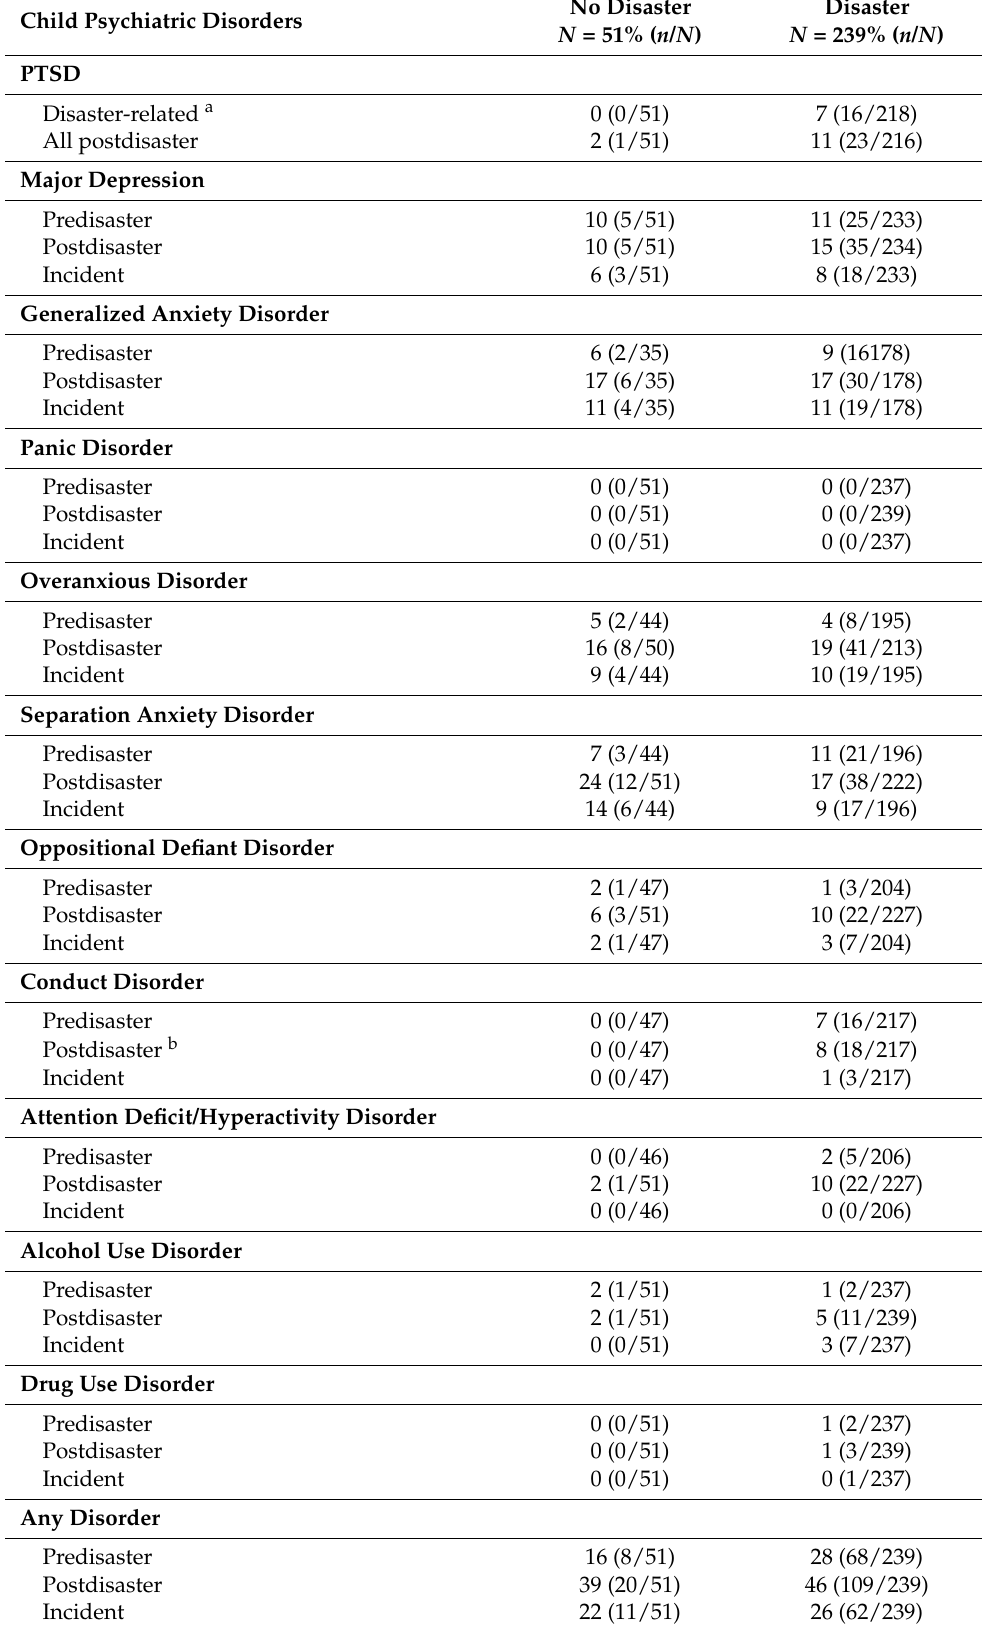
Table 2. Child psychiatric disorders by disaster